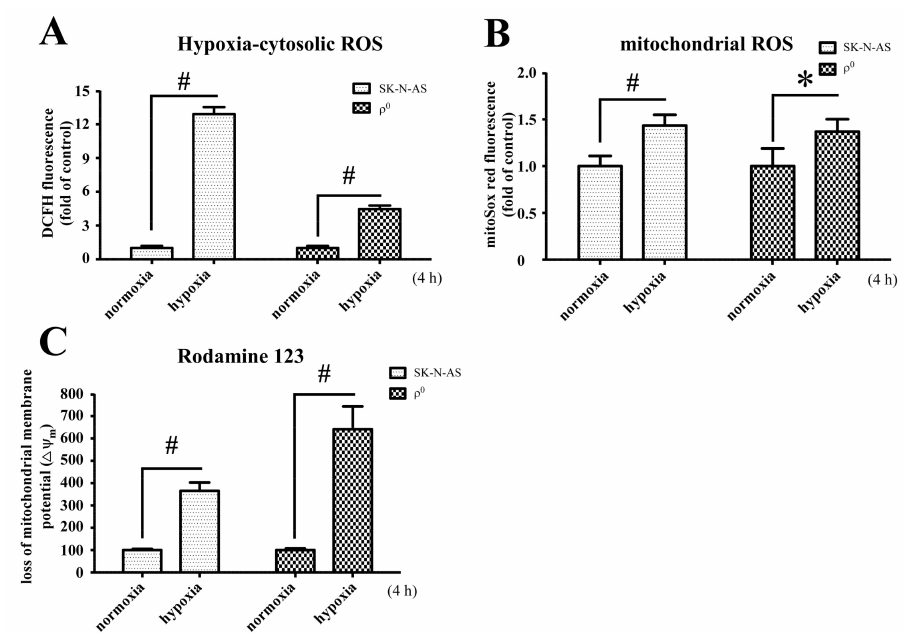
Figure 2. Hypoxia and mitochondrial DNA (mtDNA) affect the production of ROS and loss of mitochondrial membrane potential ( ∆ ψ m ). Intracellular H 2 O 2 production ( A ); or mitochondrial superoxide ( B ) under normoxia or after hypoxia for 4 h were determined by flow cytometry with DCFH-DA or MitoSox red individually in both SK-N-AS and (cid:36) 0 cells; ( C ) Loss of mitochondrial membrane potential in normoxic or hypoxic SK-N-AS and (cid:36) 0 cells were measured by Rodamine 123. The percentages loss of ∆ ψ m indicated the number of ∆ ψ m collapsed cells after exposure to hypoxia. These results are shown as mean ± SD of more than three independent experiments. Statistical significance (* p < 0.05, # p < 0.005) was determined using the one-way ANOVA compared to normoxia.